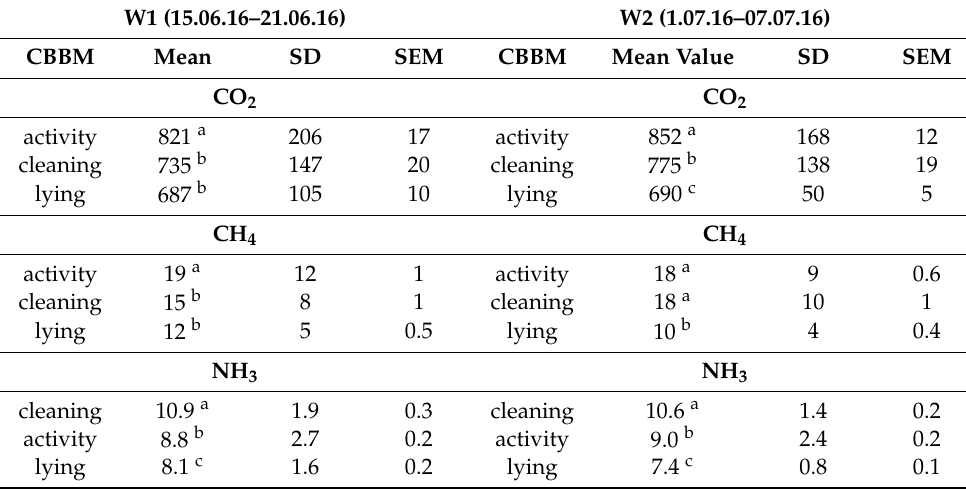
Table 5. Results of statistical analyses on gas concentrations (ppm), in the central SLs, at different cow behaviour and barn management (CBBM) in the weeks considered, during periods at low airflow velocities (v ≤ 0.5 ms − 1 ). Groups of values (a, b, c) that do not share a letter are significantly